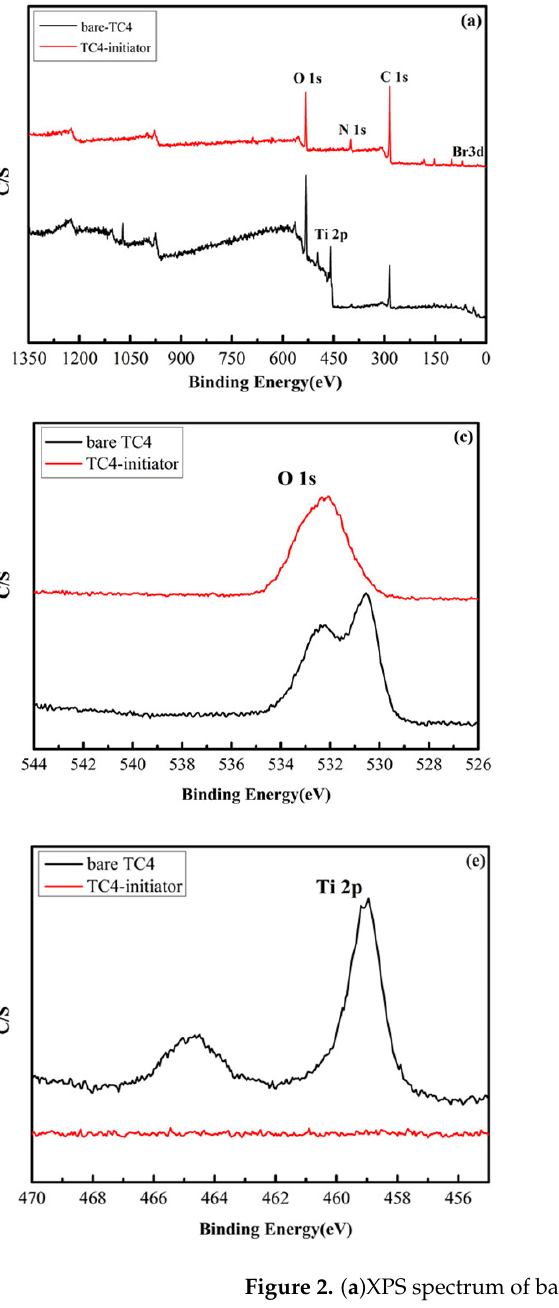
Figure 3. The FT − IR spectra of gel 1, gel2, gel 3, and gel 4. 3.3. Hydrogel Bonding Using ATRP technology, a certain thickness of gel1 was formed between two pieces of TC4 (as shown in Figure 4a), and it was soaked in water for 12 hours to reach the swelling equilibrium (as shown in Figure 4b). When swollen in water, interfacial stress will be generated between the hydrogel and the underlying substrate because the hy- drogel is a three-dimensional network structure. Therefore, if the binding bond of the hydrogel to TC4 is strong enough to overcome this stress, the hydrogel remains bound to TC4. On the other hand, if the binding bond of the hydrogel to TC4 is weak, the hydrogel will fall off the surface of TC4. It can be seen from Figure 4b that the hydrogel did not fall off from TC4, indicating that the titanium alloy is strongly bound to the hydrogel. To further verify the strong binding of TC4 to the hydrogel, I clamped TC4 with two twee- zers and stretched it in opposite directions (as shown in Figure 4c). After breaking, it was